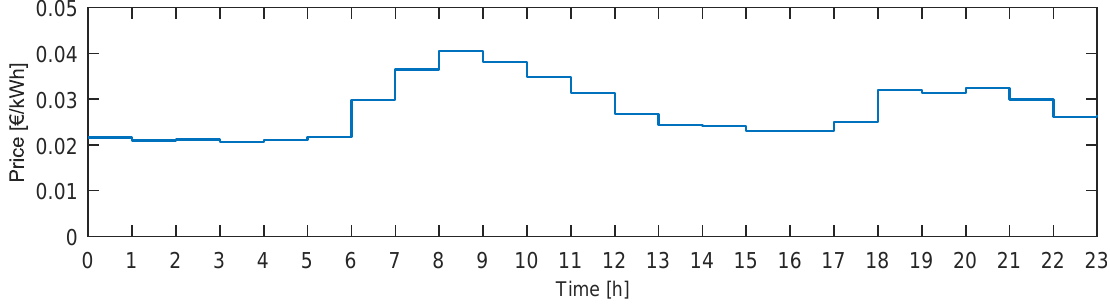
Figure 5. Dynamic electricity pricing scheme for the end-users of the business park